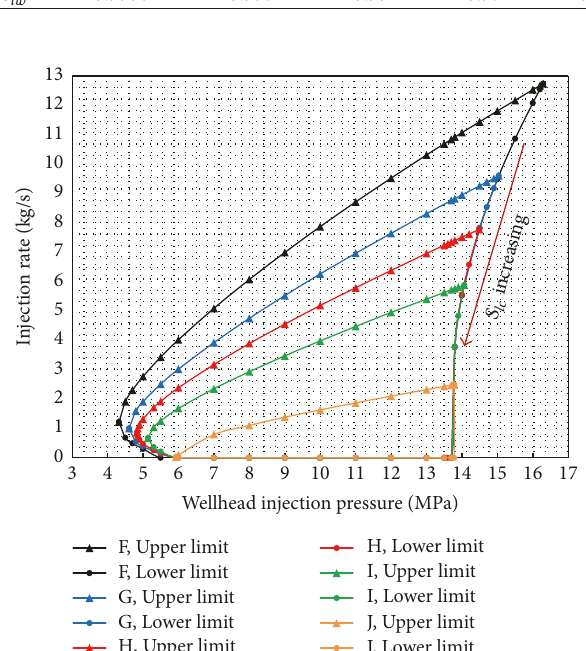
Figure 8: Relationship diagram between wellhead injection pres- sure and injection rate at different 𝑆 𝑙𝑐 .